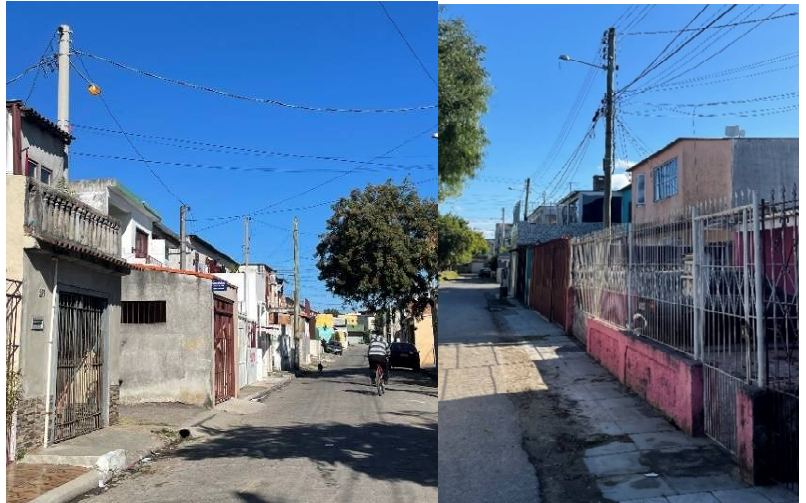
Figure 2. Example of significant transformation and expansions encroaching into public space in the Guabiroba development. Photos by the authors.